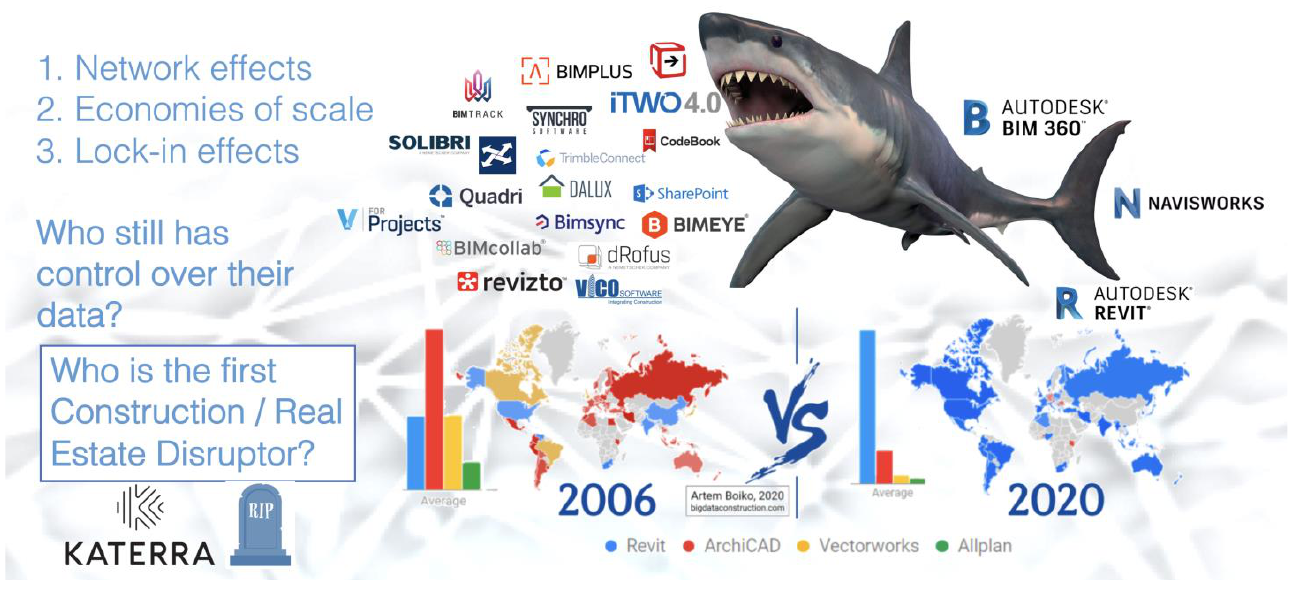
Figure 4. “ The winner takes it all ”— Growing market concentration of platforms shown in the field Figure 4. “The winner takes it all”—Growing market concentration of platforms shown in the of Building Information Modeling ( “ BIM ” ) between 2006 and 2020 (reprinted with permission from field of Building Information Modeling (“BIM”) between 2006 and 2020 (reprinted with permission [53]). from